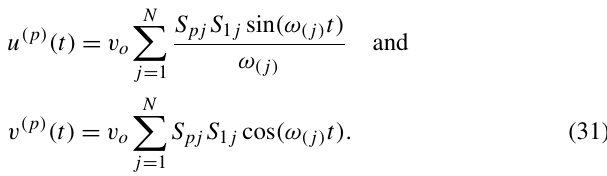
Table 1 (500 ensembles scaled), Table 2 (500 ensembles